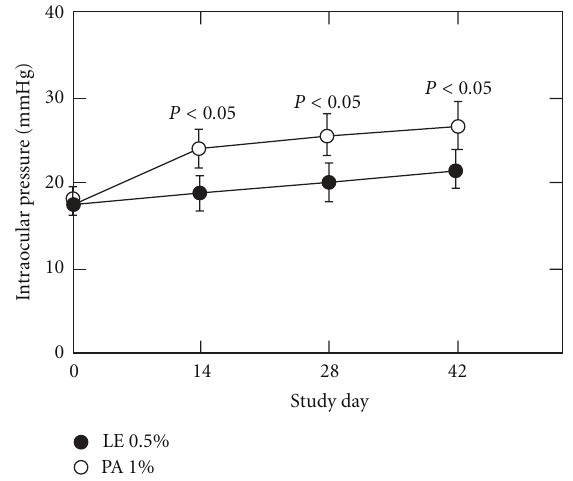
Figure 5: Mean (SEM) IOP for subjects receiving loteprednol etabonate and prednisolone. Within-treatment significant changes from baseline are indicated adapted from